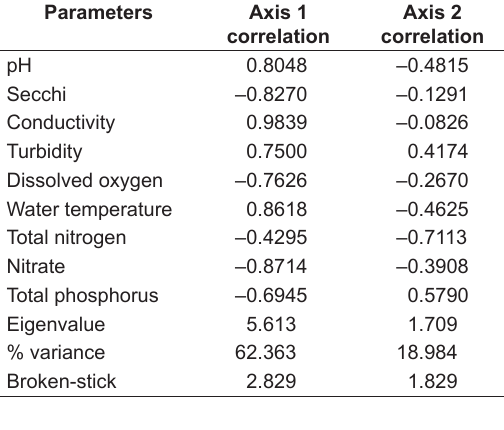
Table 1. Correlation and performance values obtained through Principal Component Analysis (PCA) to Rosana Reservoir from April to August/2002.